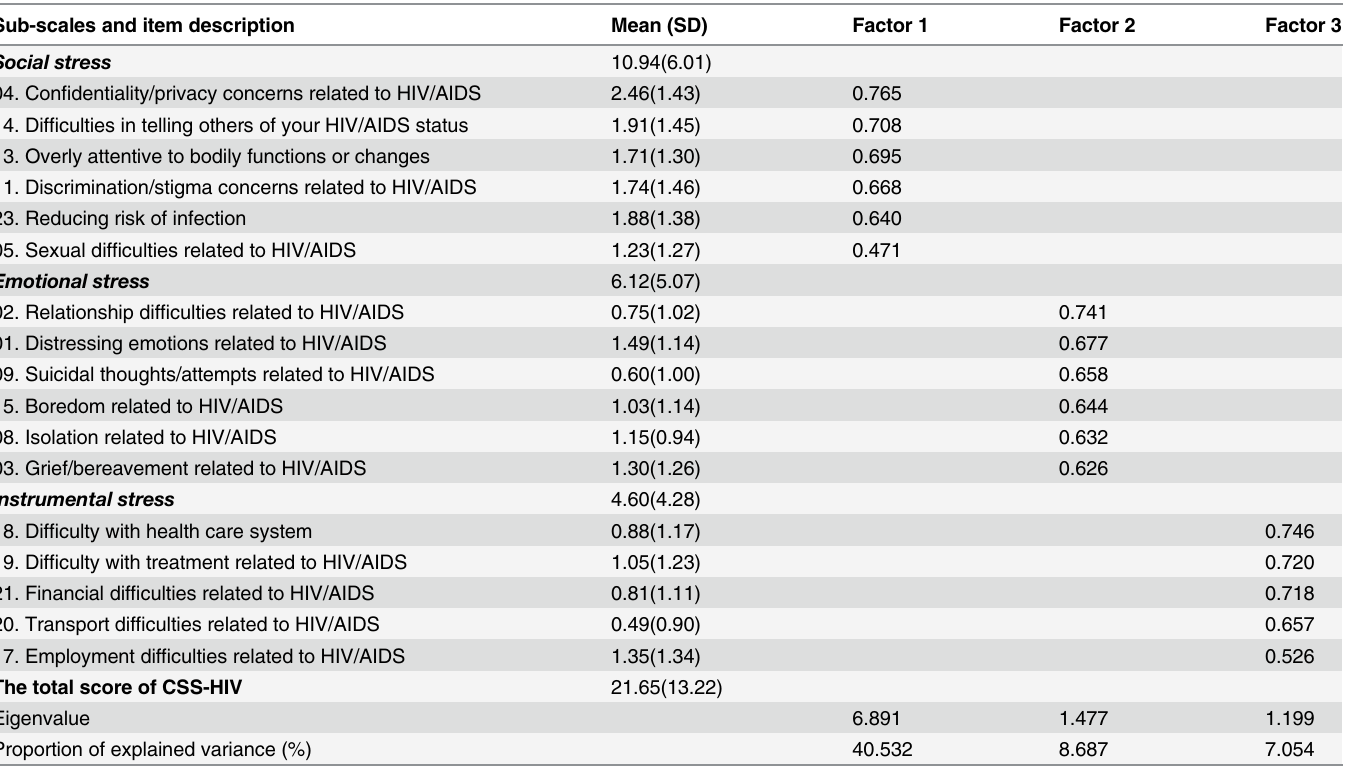
Table 2. Rotated factor matrix for the 17-item CSS-HIV.